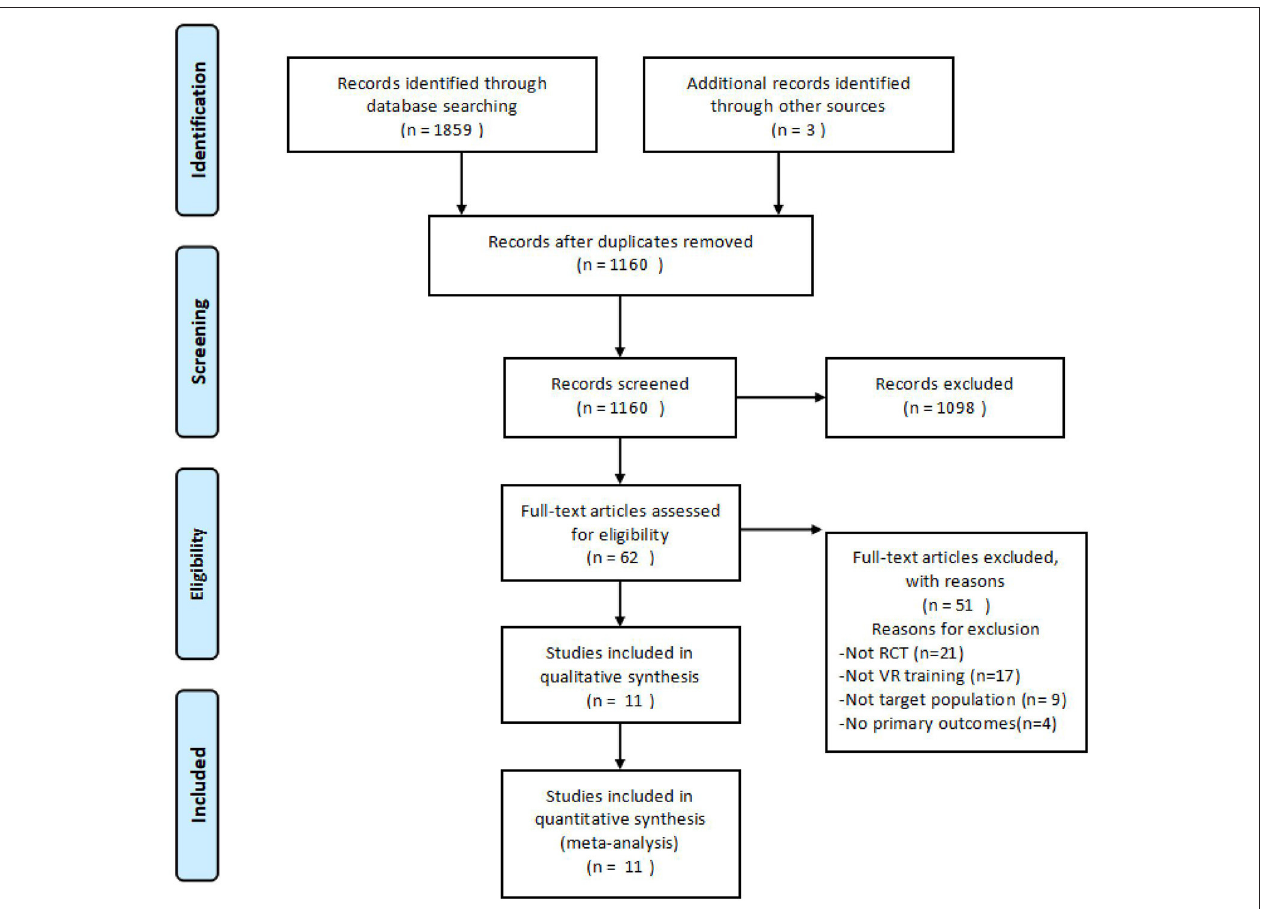
FIGURE 1 | Flow chart of the literature